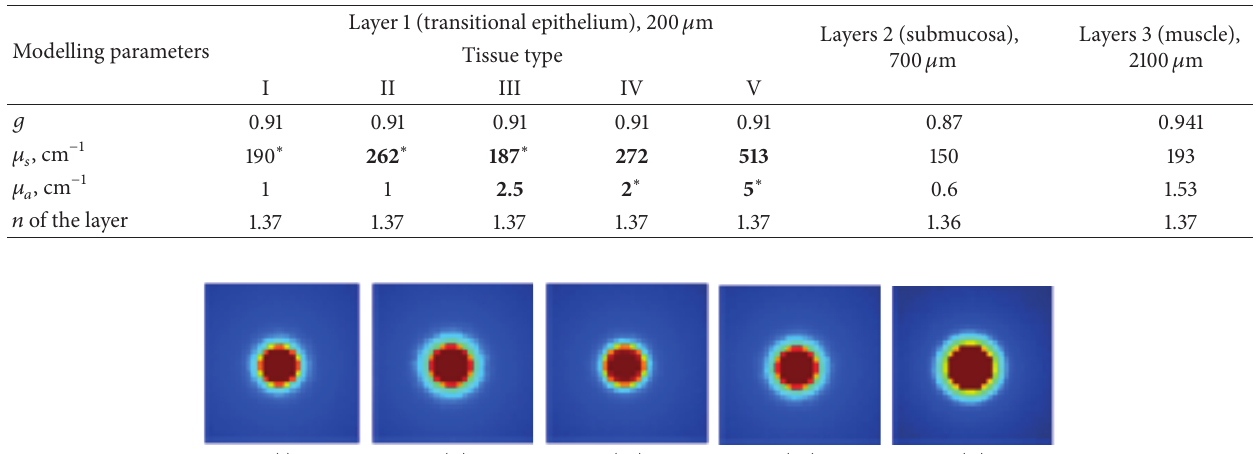
Table 2: Input parameters for Monte Carlo modelling of light distribution in the bladder wall. The calculations of the parameters marked with ∗ are based on the electromagnetic wave theory.